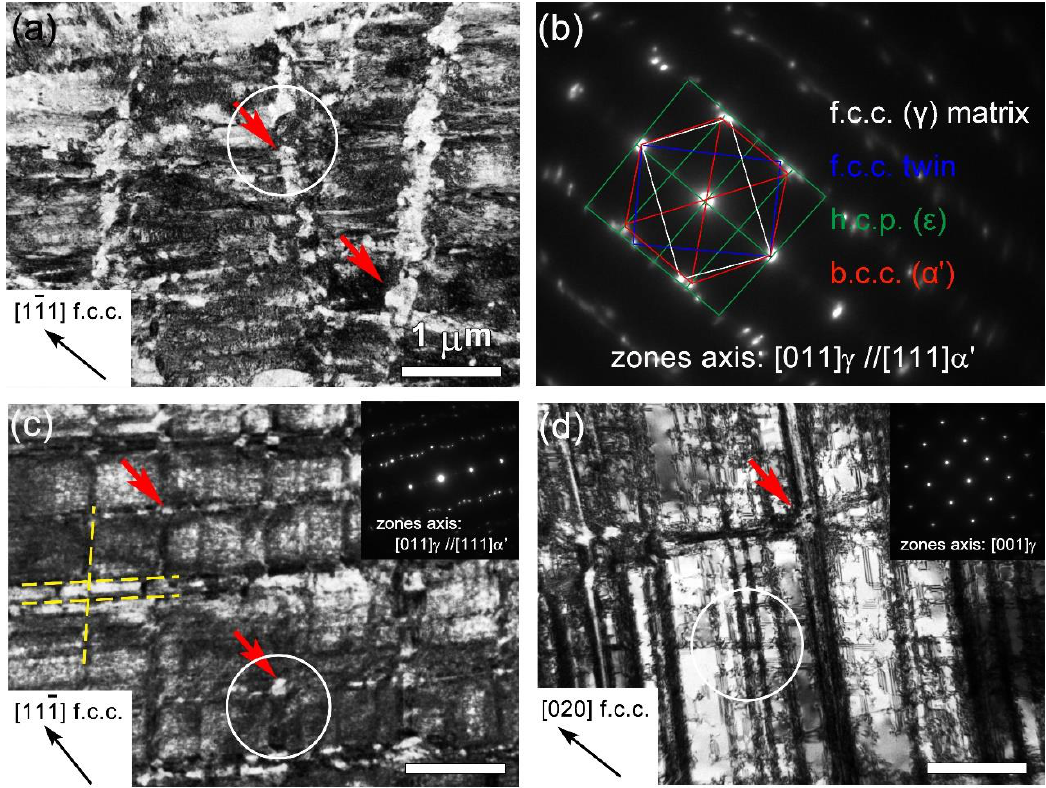
Figure 2. Representative TEM images showing the microstructure gradient of as-SMATed sample: ( a ) at a depth of about 50 μm from the surface, ( b ) the corresponding SAED pattern of microstructure in ( a , c ) about 100-μm-deep and ( d ) about 250-μm-deep. The red arrows mark the granular martensite, and the dotted yellow lines in ( c ) indicate the martensitic nano-lamellae. ( a ,c, d ) share the same ruler, and the white circle is selected as the SAED test area.